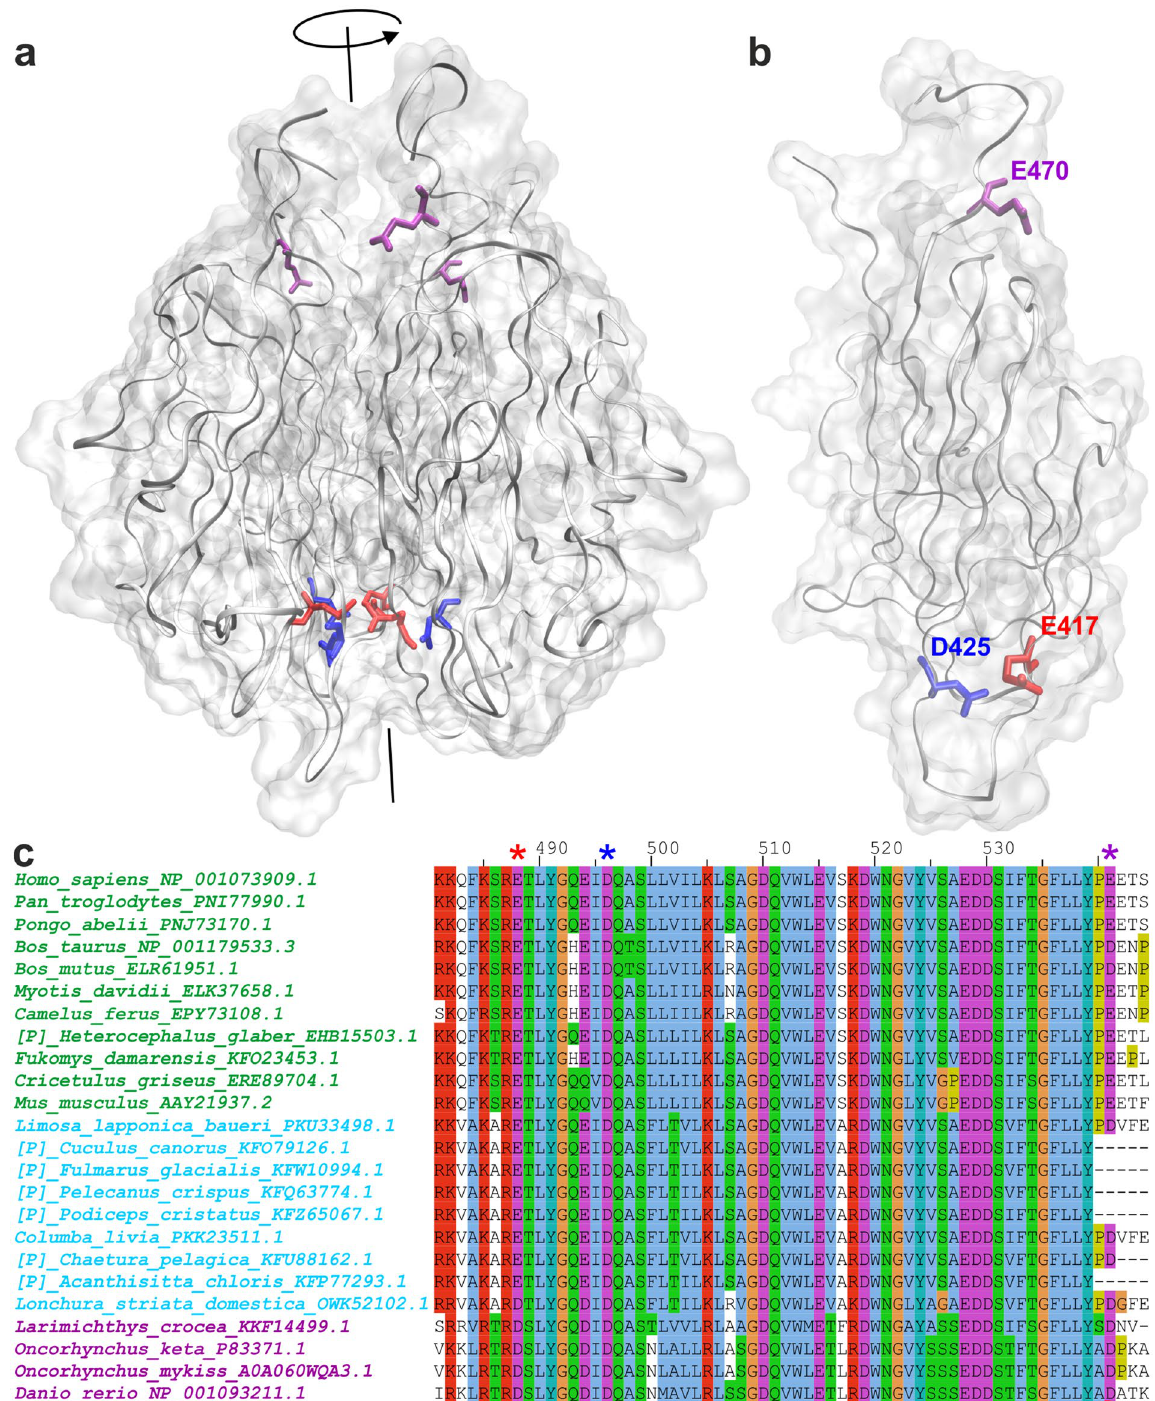
Figure 1. Molecular model of the gC1q domain of otolin-1 from human (hOtolC1q) and zebrafish (dOtolC1q). ( a , b ) Model of hOtolC1q ( a ) trimer and ( b ) monomer obtained through EOM analysis based on small angle X-ray scattering data 33 . The predicted shape of the molecule is shown in light grey, the protein backbone is shown as grey ribbons, E417 is shown in red, D425 in dark blue, and E470 in purple. Axis of a trimer is shown in black. The images were prepared using VMD software (University of Illinois, https:// www. ks. uiuc. edu/ Resea rch/ vmd/) 65 . ( c ) Part of a multiple sequence alignment of otolin-1 sequences from mammals (green), birds (blue) and fish (purple), including E417 (red asterisk), D425 (dark blue asterisk) and E470 (purple asterisk) residues of hOtolC1q. Annotations on the left include organism names and NCBI gene identifiers. [P] indicates partial protein sequences. The alignment is coloured using Clustal colour scheme. Briefly, the colours mark at least partially conserved residues. Blue indicates hydrophobic residues, red—basic, magenta—acidic, green—polar, cyan—aromatic, orange—glycines, yellow—prolines, pink— cysteines (absent in the analysed fragment). A more detailed description is available at https:// www. jalvi ew. org/ help/ html/ colou rSche mes/ clust al. html. The alignment was performed using Clustal X 66 and visualized using Jalview 67